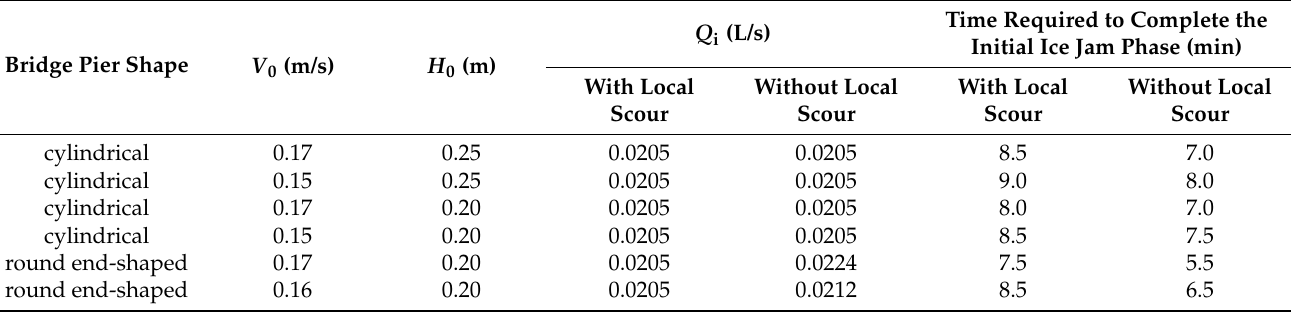
Table 4. Comparison of the time required for an ice jam to reach an equilibrium condition with and without a local scour around the